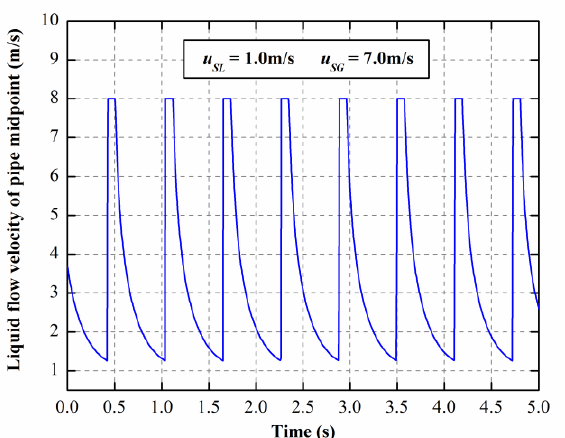
Figure 3. The transient pattern of slug flow in two typical moments (( a ): at t = t 1 ; ( b ): at t = t 2 ). The liquid flow velocity u L (0.5 L , t ) is depicted in Figure 4, which could reflect the features of intermittency. This characteristic will lead to some flow parameters in Equa- tion (2) varying with time, which would affect the dynamic responses of the pipes greatly.